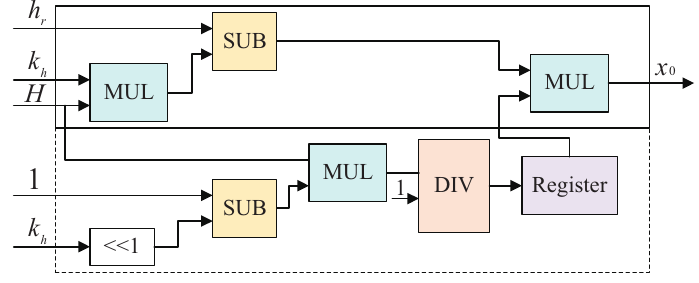
Figure 5. Hardware structure for calculating x 0 ; the dashed part is run only